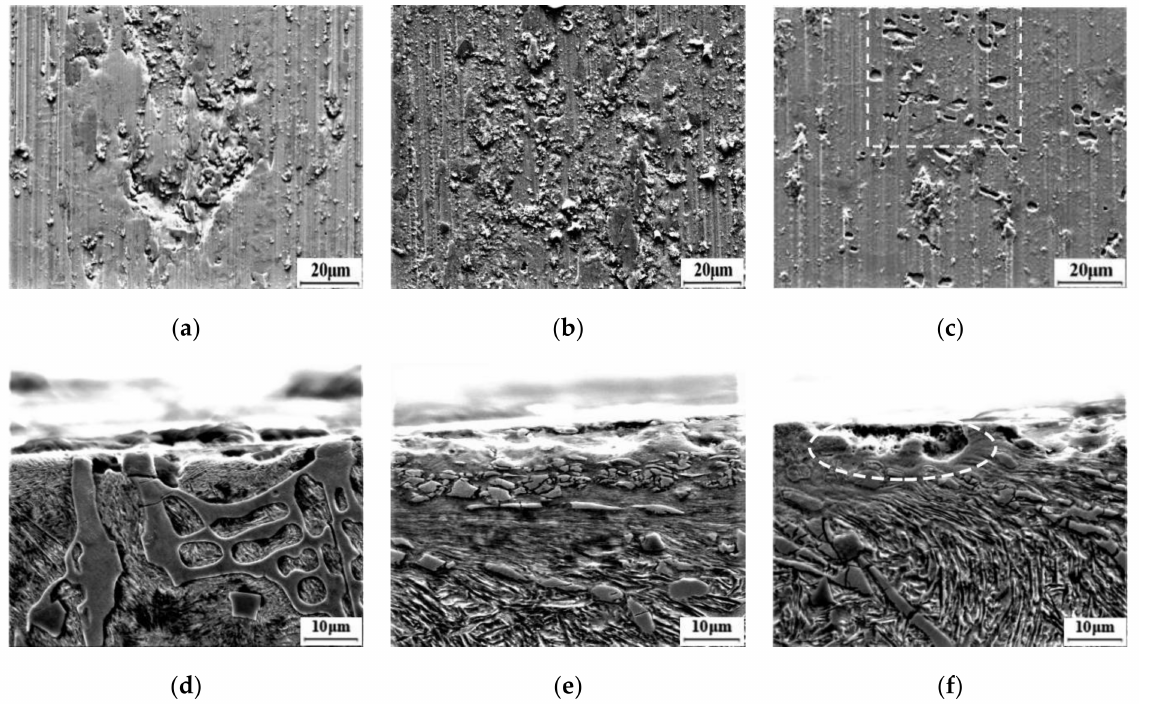
Figure 12. Worn surfaces and sub-surfaces morphology of samples: ( a , d ) as-cast, ( b , e ) tq = 90 s, and ( c , f ) tq = 120